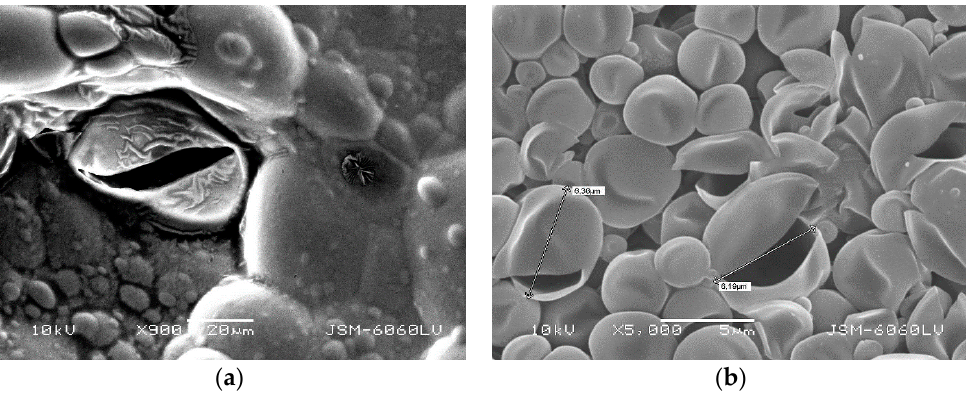
Figure 8. Pressure-activated citronella oil microcapsules: ( a ) produced with complex coacervation (SEM, 900×); ( b ) produced with in situ polymerization (SEM, 5000×).